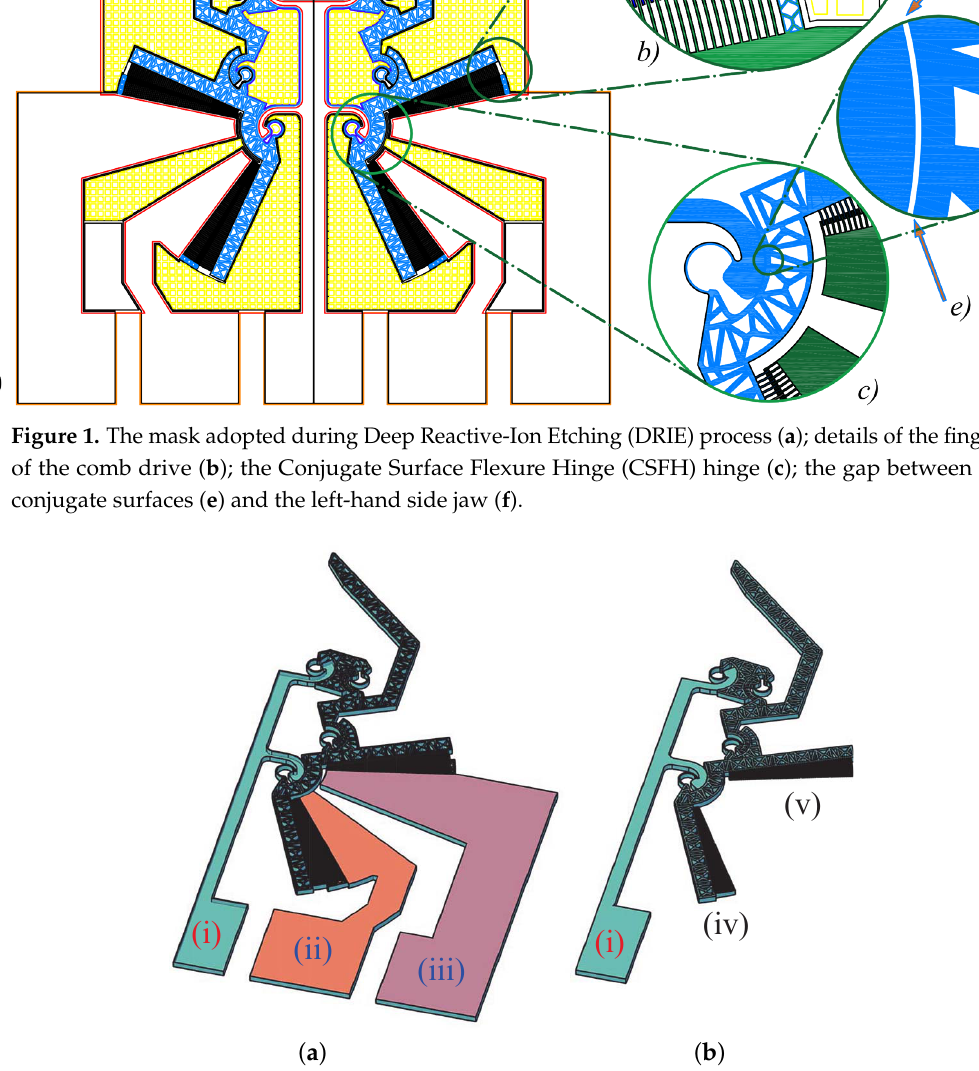
Figure 2. Model of the right jaw of the microgripper with ( a ) and without ( b ) the control pads: (i) device anchor; (ii) opening control pad; (iii) closing control pad; (iv) and (v) mobile fingers engaged with (ii) and (iii),